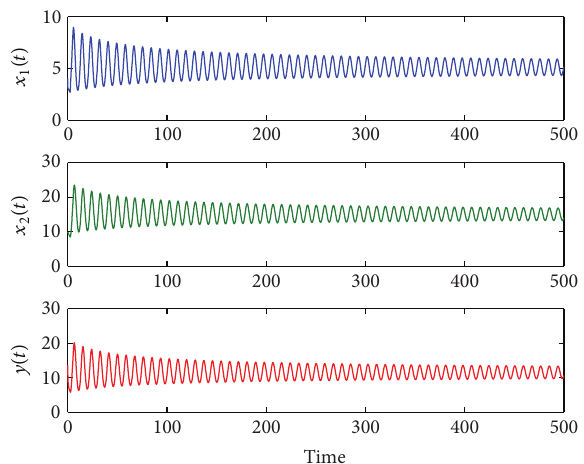
Figure 1: Dynamical responses of model (5) with 𝜏 = 1.26 , which shows that model (5) is stable around the interior equilibrium (5.058, 14.932, 11.395) .